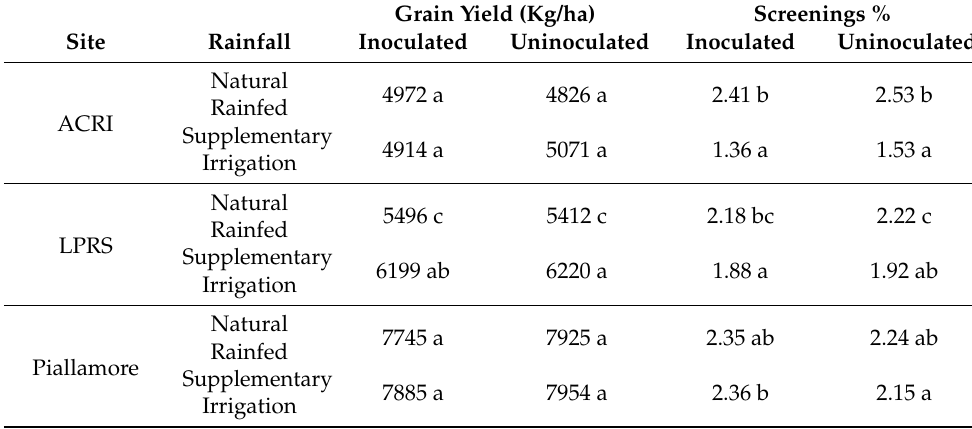
Table 2. Grain yield and screenings of three bread (LRPB Lancer, Suntop and LRPB Hellfire) and three durum (DBA Lillaroi, Jandaroi and DBA Aurora) wheat varieties when inoculated or uninoculated with Fusarium crown rot under natural rainfed and supplementary irrigation scenarios across three trial sites; Australian Cotton Research Institue (ACRI), Liverpool Plains Research Site (LPRS) and Piallamore, in 2021. Values within a site followed by the same letter are not significantly difference at the 95% confidence